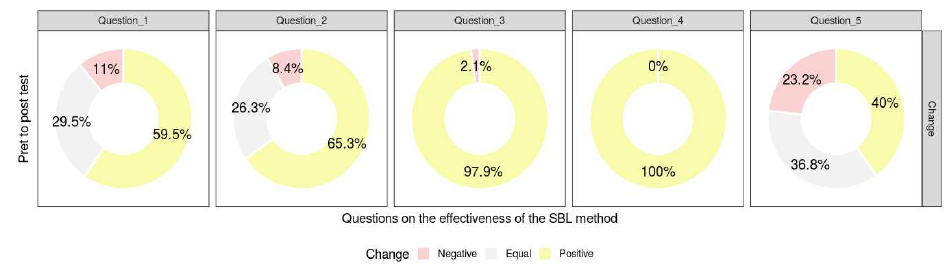
Figure 1. Change of SBL perception.